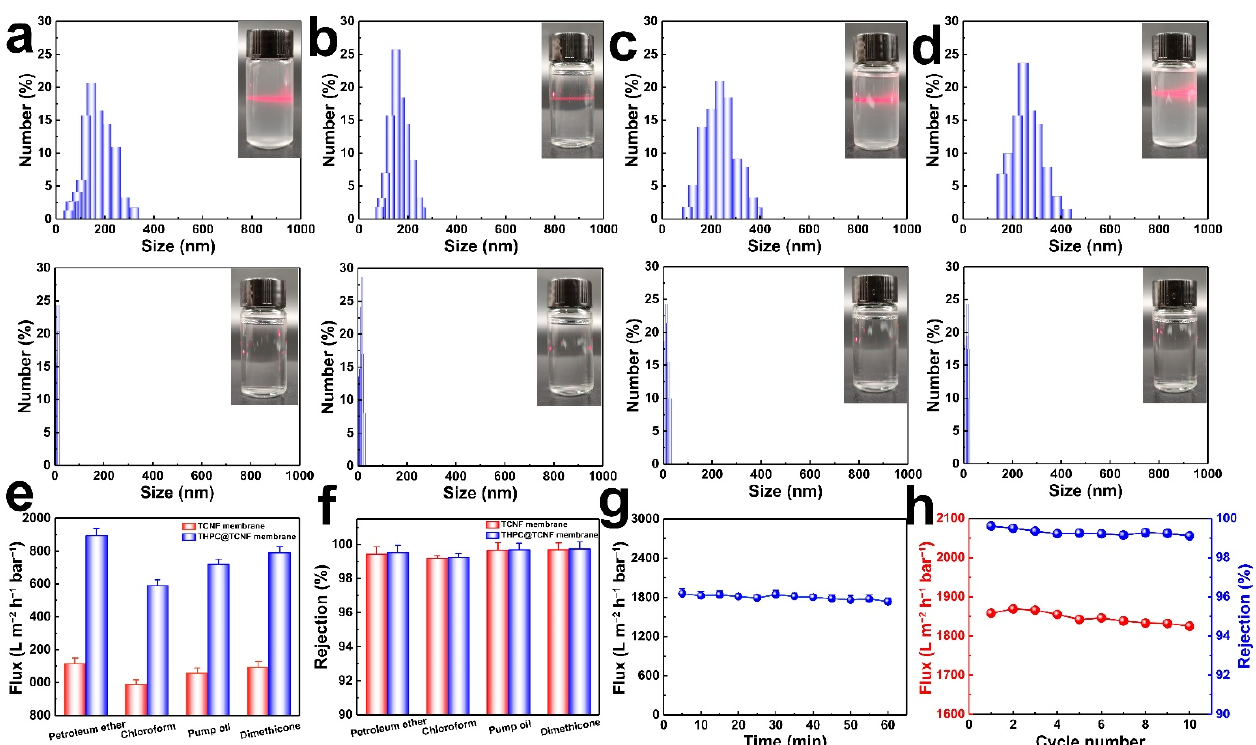
Figure 5. ( a – d ) Size distribution and photographs of oil/water nano-emulsions (petroleum ether, chloroform, pump oil and dimethicone) before (top) and after filtration (bottom). ( e ) Water permeate flux and ( f ) oil rejection of TCNF membrane and THPC@TCNF membrane. ( g ) The relationship between water permeate flux of THPC@TCNF membrane and separation time. ( h ) Cycle performance of THPC@TCNF membrane for the separation of petroleum ether/water